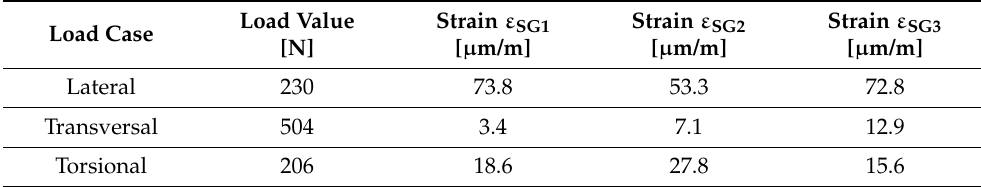
Table 6. Experimental strain values measured in case of investigated load cases for hood “B”.